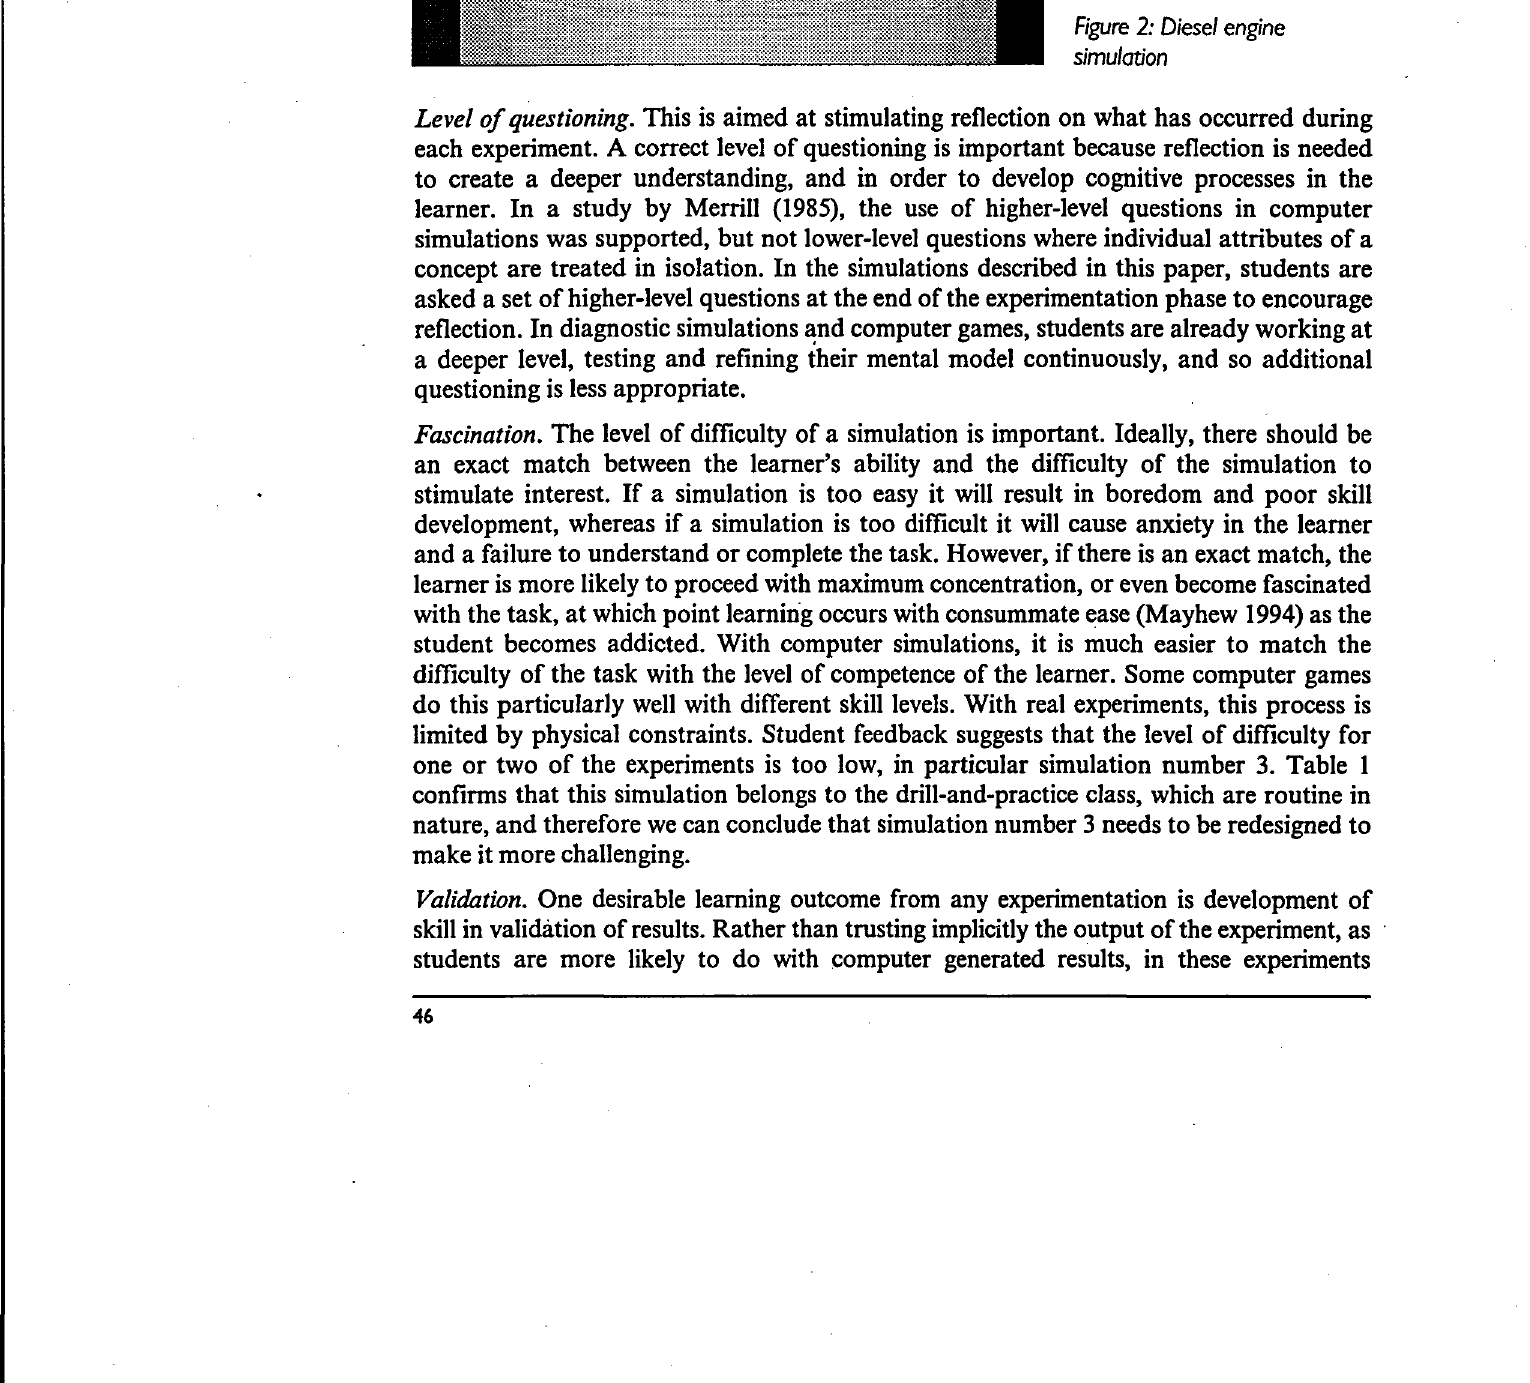
Figure 2: Diesel engine